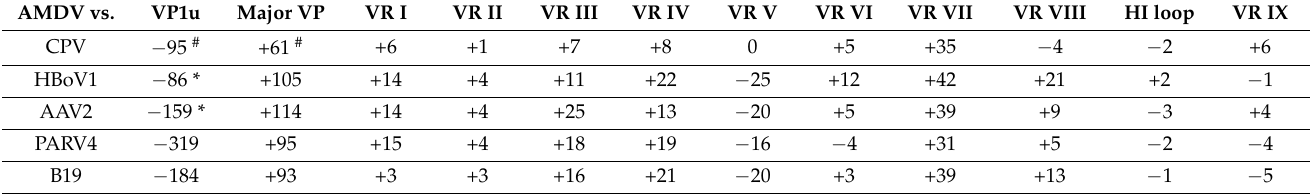
Table 2. VP and loop amino acid length comparison of AMDV with other members of the Parvovirinae . AMDV